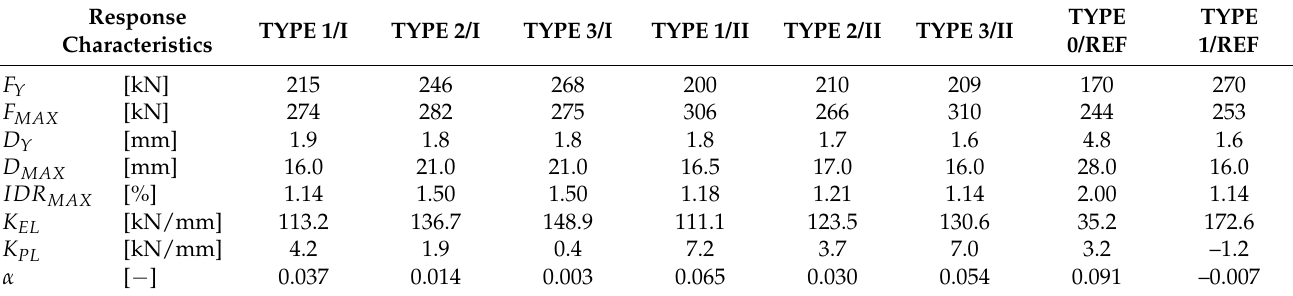
Table 3. Characteristic points on the models’ idealised bilinear